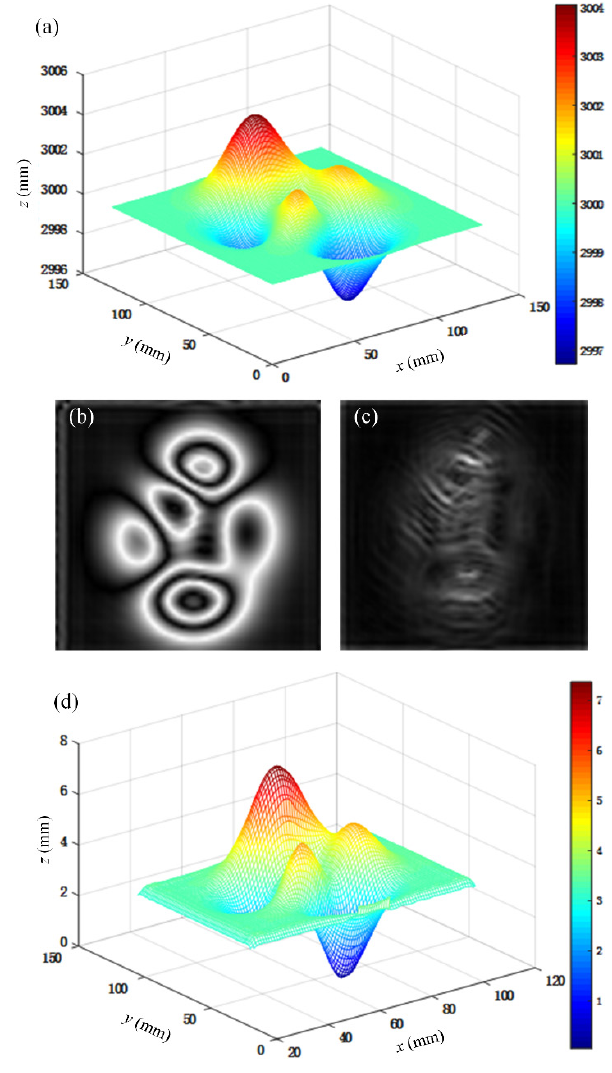
Figure 5. Reconstruction model and results of phase expansion of the Peaks model. ( a ). The peaks model diagram. ( b ). The phase wrapping diagram. ( c ). The phase quality diagram. ( d ). Phase recovery of Peaks